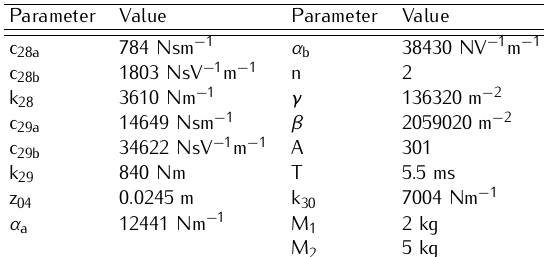
Table 6. Parameters of suspension and seat.